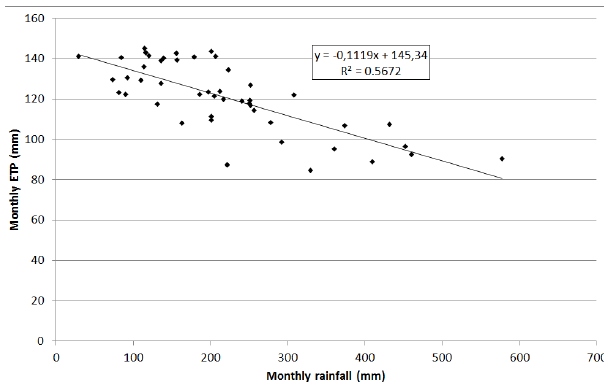
Figure 1. Example of regression for Brasilia, month of